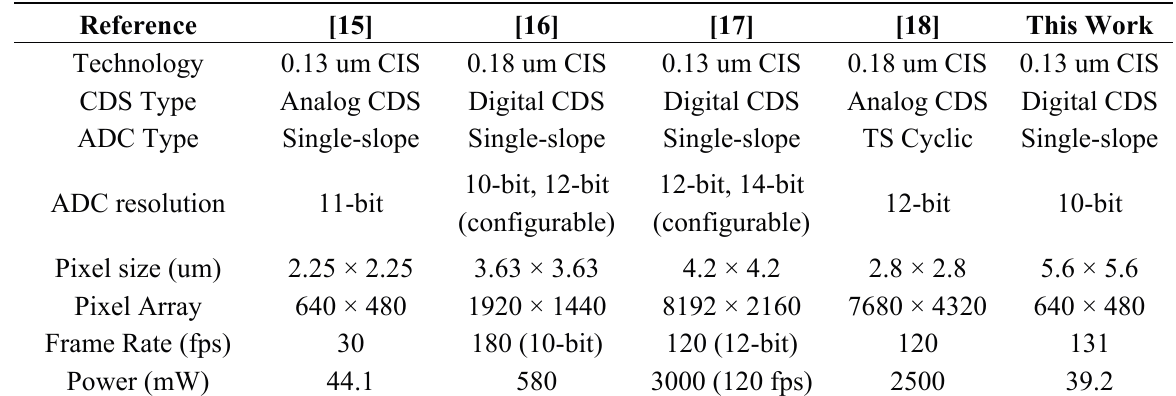
Table 4. Performance comparison